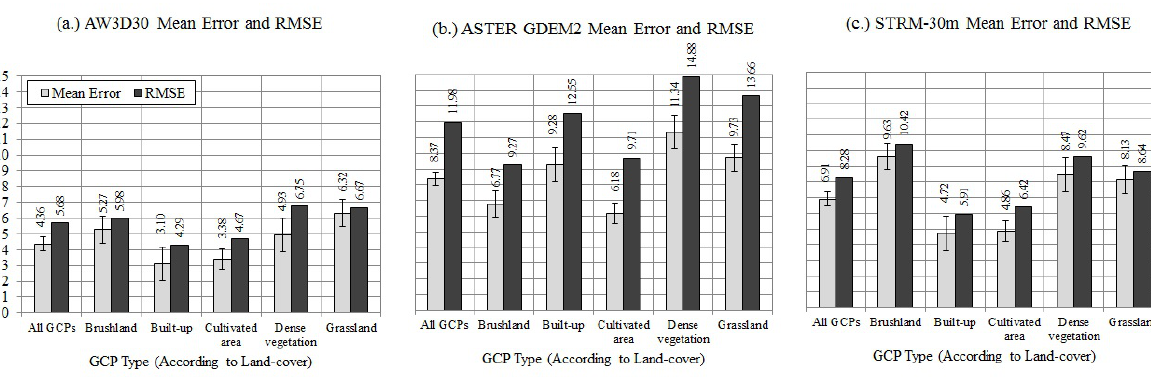
Figure 3: Mean error and RMSE of DEMs (indicated by numerical values) according to land-cover type. Error bars represent 95% confidence intervals of the